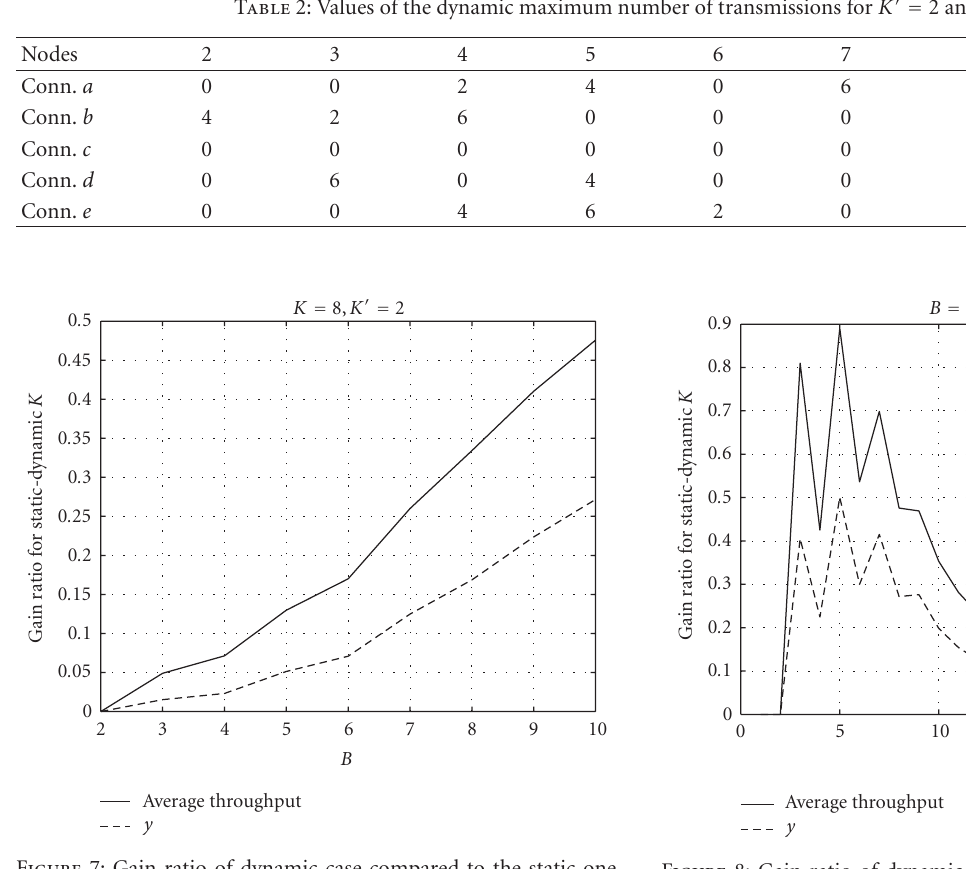
Figure 8: Gain ratio of dynamic case compared to the static one versus K for K (cid:5) = 2 (linear